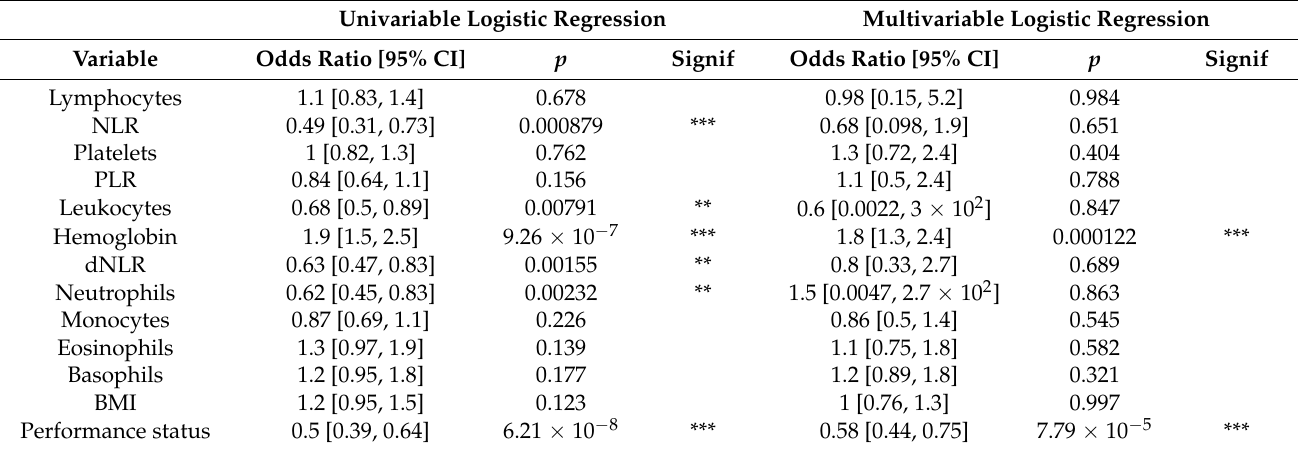
Table 2. Logistic regression analysis for disease control. Univariable Logistic Regression